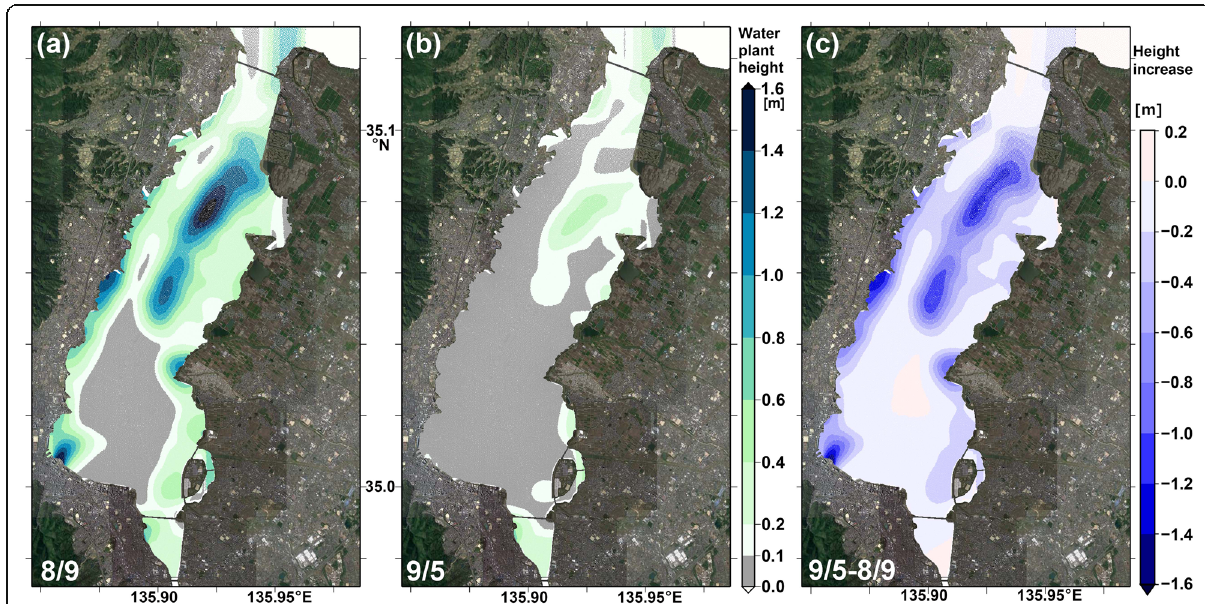
Fig. 6 Distribution of the macrophyte height (m) in the southern basin of Lake Biwa on 9 August 2018 ( a ) and on 5 September ( b ). c Temporal change in the macrophyte height derived by subtracting the height on 5 September ( b ) from the height on 9 August ( a )